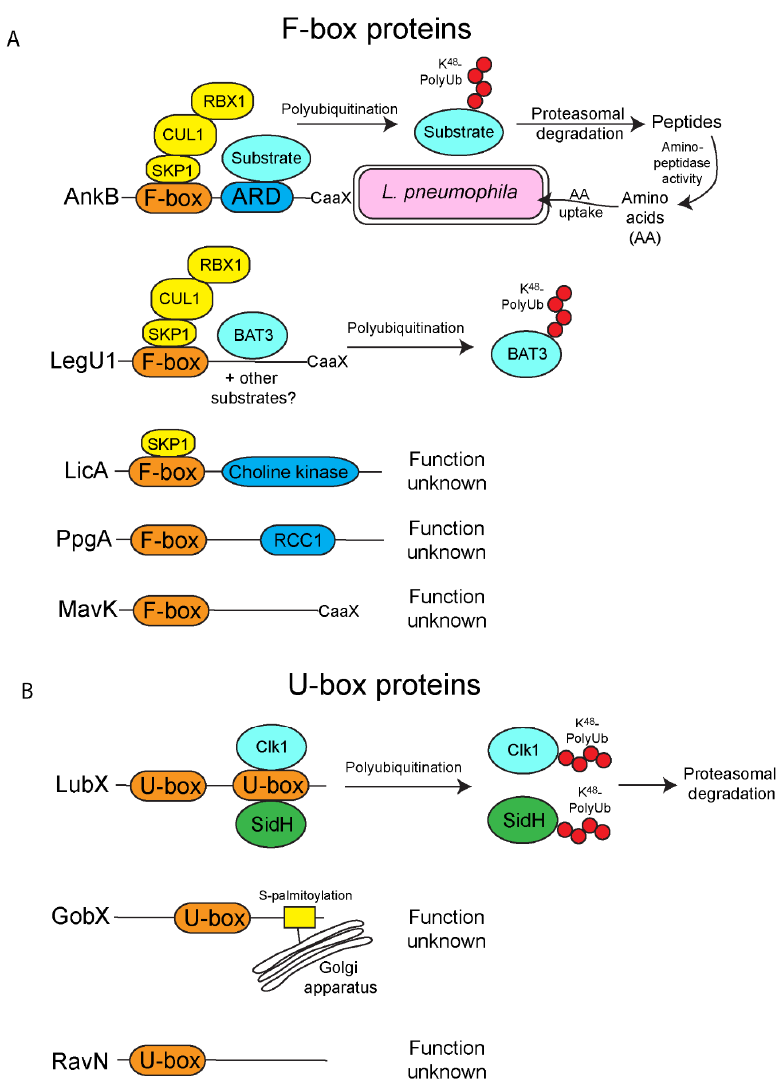
Figure 1. The “classical” E3-ubiquitin ligases of L. pneumophila . L. pneumophila has multiple effectors that show homology to the classical F-box and U-box families that are widespread in eukaryotes. ( A ) F-box effectors of L. pneumophila . There are five known L. pneumophila F-box effectors. Firstly, AnkB, which harbors an F-box, an ankyrin repeat domain (ARD) and a C-terminal CaaX motif that is targeted for farnesylation, enabling localization to the Legionella -containing vacuole, (LCV) membrane. The F-box domain of AnkB interacts with the host Skp1-Cul1 (SCF) complex to promote the decoration of the LCV with K 48 -linked polyubiquitinated proteins. These proteins are ultimately degraded by the host proteasomes to generate copious quantities of amino acids required for metabolism of L. pneumophila . LegU1 also interacts with the SCF complex and directs the polyubiquitination of the host protein, BAT3. It is possible LegU1 also targets other as yet unidentified host proteins. Similar to AnkB, LegU1 also has a C-terminal CaaX motif, targeting this effector to host membranes. LicA interacts with the Skp1 component of the SCF complex but not Cul1, suggesting a LicA forms a non- canonical complex, and the functional role of this effector is unknown. The functional roles of MavK, which also has a C-terminal CaaX motif and PpgA are unknown. ( B ) U-box effectors of L. pneumophila . L. pneumophila injects three effectors with the U-box domain. LubX ubiquitinates the host factor Clk1. Additionally, LubX functions as a metaeffector and directs ubiquitination of the injected effector, SidH, which is then targeted for proteasomal-mediation degradation. GobX is targeted to the Golgi apparatus where it is embedded into the membrane through S-palmitoylation modification, however the functional role of GobX is unknown. RavN also harbors the U-box domain, but the role of this effector is